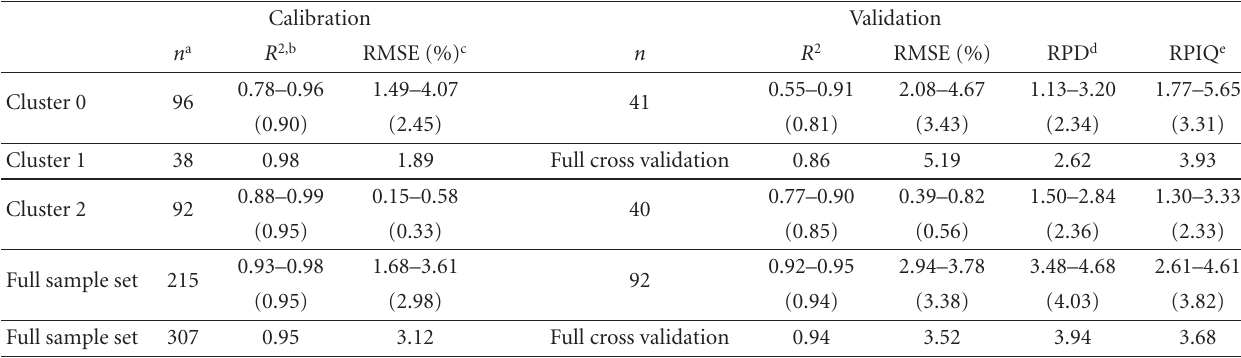
Table 7: Detailed partial least squares regression model results for soil total carbon (C t ) prediction from the subsets of mid-infrared di ff use reflectance spectra based on spectral classification with k -means cluster analysis. The range of values reflects the results of 10 random iterations of the models, and the number in parentheses is the mean. Detailed results are also given for full sample set models with no subsetting for comparison. For models with full cross validation (i.e., leave-one-out cross validation), the same samples used to calibrate the model were used to validate the